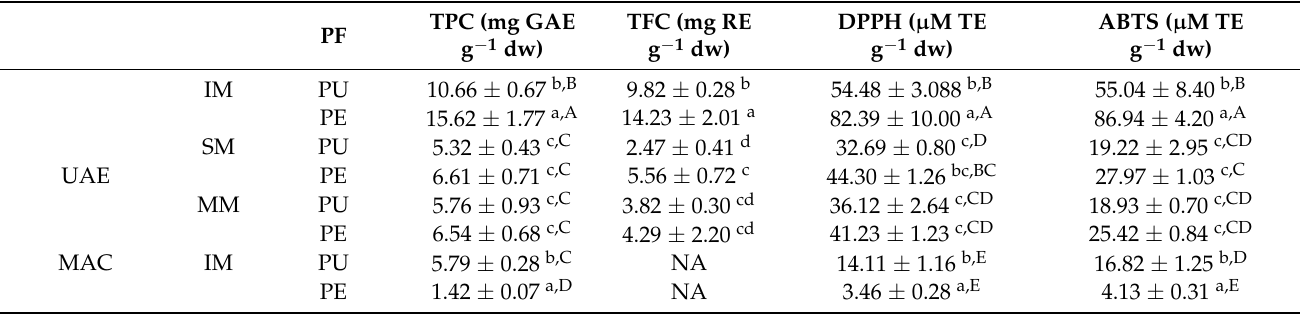
Table 2. Total phenolic and flavonoid contents and antioxidant activity of ciricote fruit parts at different stages of